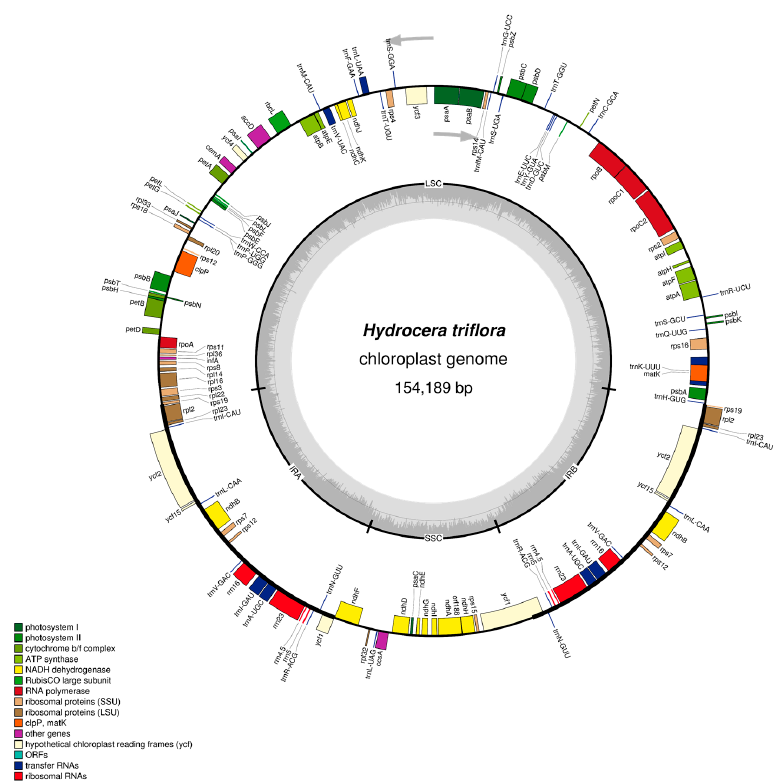
Figure 2. Gene map of the Hydrocera triflora chloroplast genome. Genes lying outside of the circle are transcribed clockwise, while genes inside the circle are transcribed counterclockwise. The colored bars indicate different functional groups. The dark gray area in the inner circle corresponds to (guanine cytosine) GC content while the light gray corresponds to the AT content of the genome. Among the 115 unique genes in I. pinfanensis and H. triflora cp genomes, 14 genes contain one intron, comprised of eight genes coding for proteins ( atpF , rpoC1 , rpl2 , petB , rps16 , ndhA , ndhB , ndhK ) and six tRNAs ( trnL-UAA , trnV-UAC , trnK-UUU , trnI-GAU , trnG-GCC and trnA-UGC ) (Table 2), while ycf3 , clpP and rps12 genes each contain two introns. These genes have maintained intron content in other angiosperms. The trans-splicing gene rps12 has its 5 ′ exon located in LSC, whereas the 3 ′ exon is located in the IRs, which is similar to that in Diospyros species (Ebenaceae) [36,41] and Actinidia chinensis (Actinidiaceae) [41]. Oddly, rps19 and ndhD genes in both species begin with uncommon [36]. However, the standard start codon can be restored through RNA editing process [42,43]. The complete cp genome of I. pinfanensis and H. triflora were found to be similar, although some slight variations such as genome size, gene loss and IR expansion and contraction factors were detected, despite the two species being from the same family Balsaminaceae. For instance, H. triflora cp genome is 1951 bp smaller than that of sister species I. pinfanensis . The SSC region of I. pinfanensis is shorter (17,611 bp) compared to that of H. triflora , which is 18,082 bp long. The GC content of H. triflora is slightly higher (36.9%) than that of I. pinfanensis (36.8%). Both species possess highest GC values in the IR regions (43.1%) compared to LSC and SSC region showing the lowest values (34.5%/34.7% and 29.3%/29.9%) respectively. The IR region is more conserved than the single copy region (SSC) in both species, due to presence of conserved rRNA genes in the IR region, which is also the reason for its high GC content. Both cp genomes are AT-rich with the genome organization and content of the two species almost the same and highly conserved, these results are similar to those of other recently published Ericales chloroplast genomes [34,36].